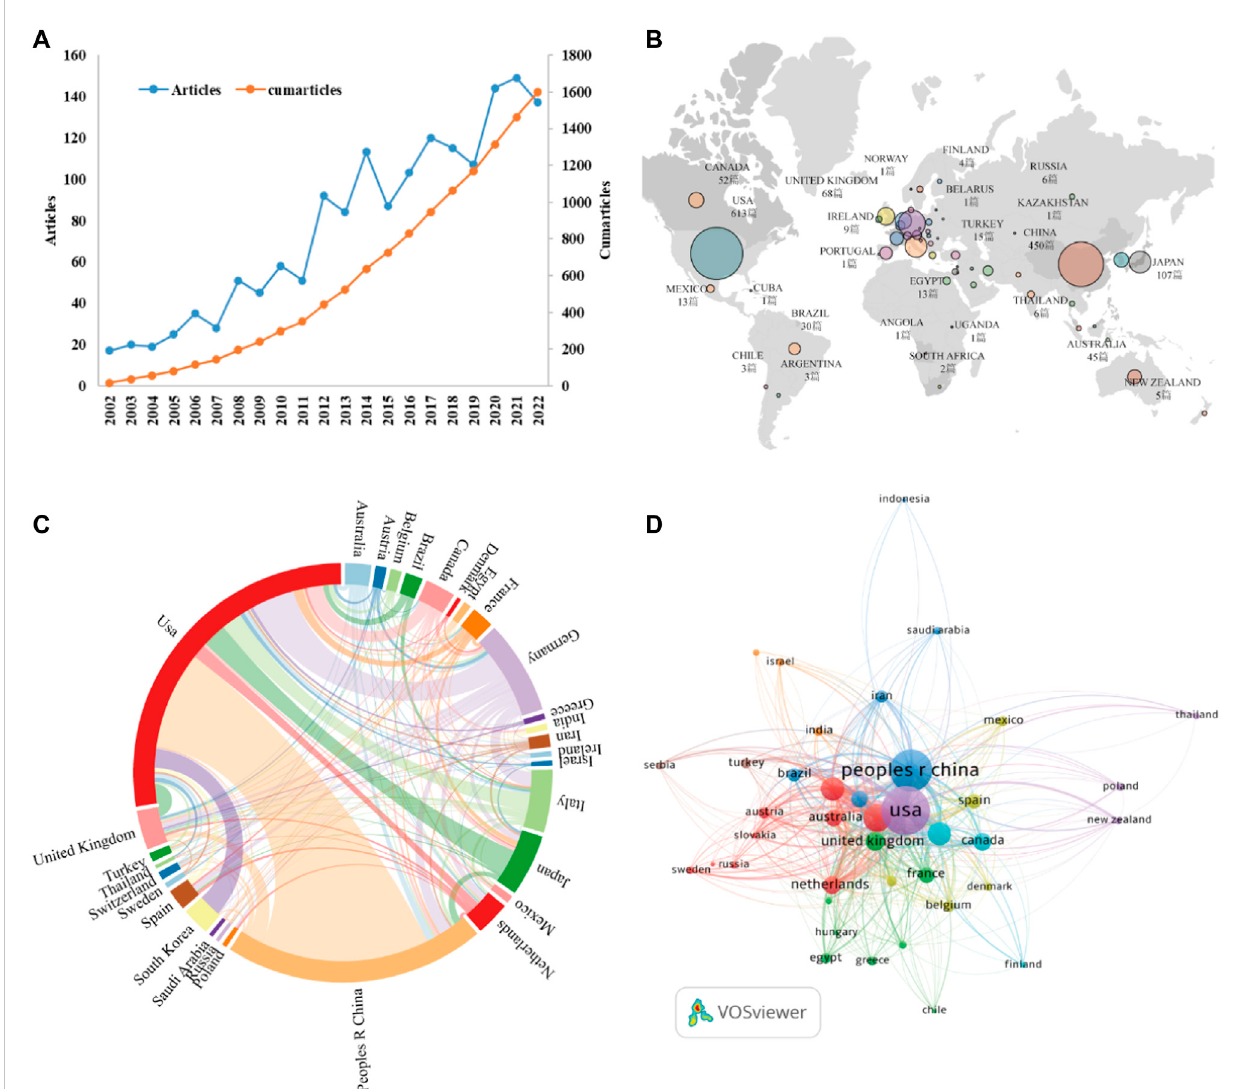
FIGURE 2 (A) Theannualnumberandcumulativepublicationsrelatedtothistopic. (B) Anoverviewofthenumberofarticlespublishedbycountryintheworld. (C) Academic cooperation between countries/regions on this topic. The thickness of segment indicated the frequency of cooperation. (D) The citation network of countries/regions mapped through